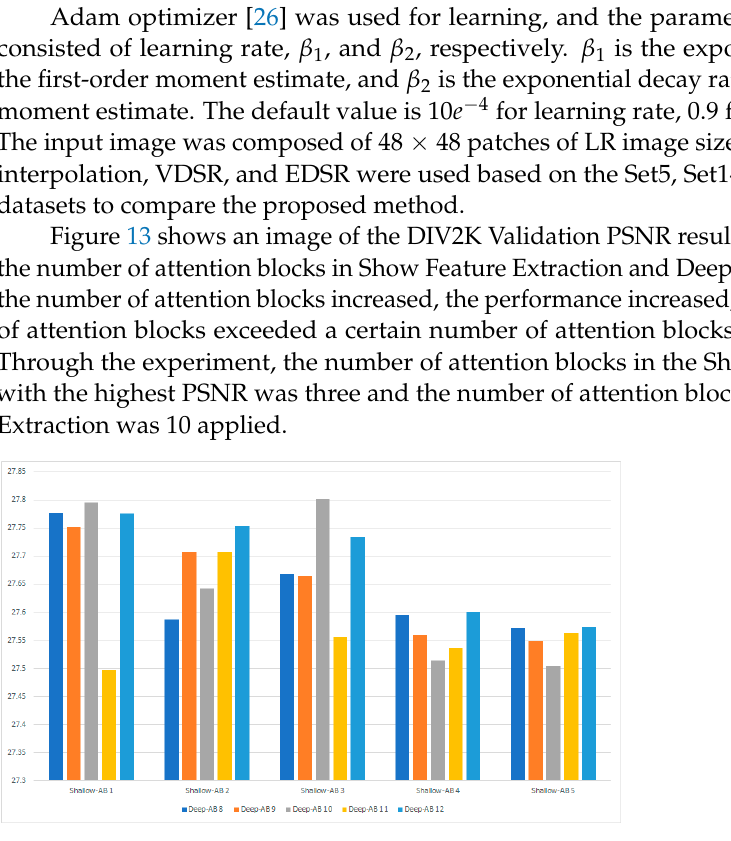
Figure 12. Upsampling.